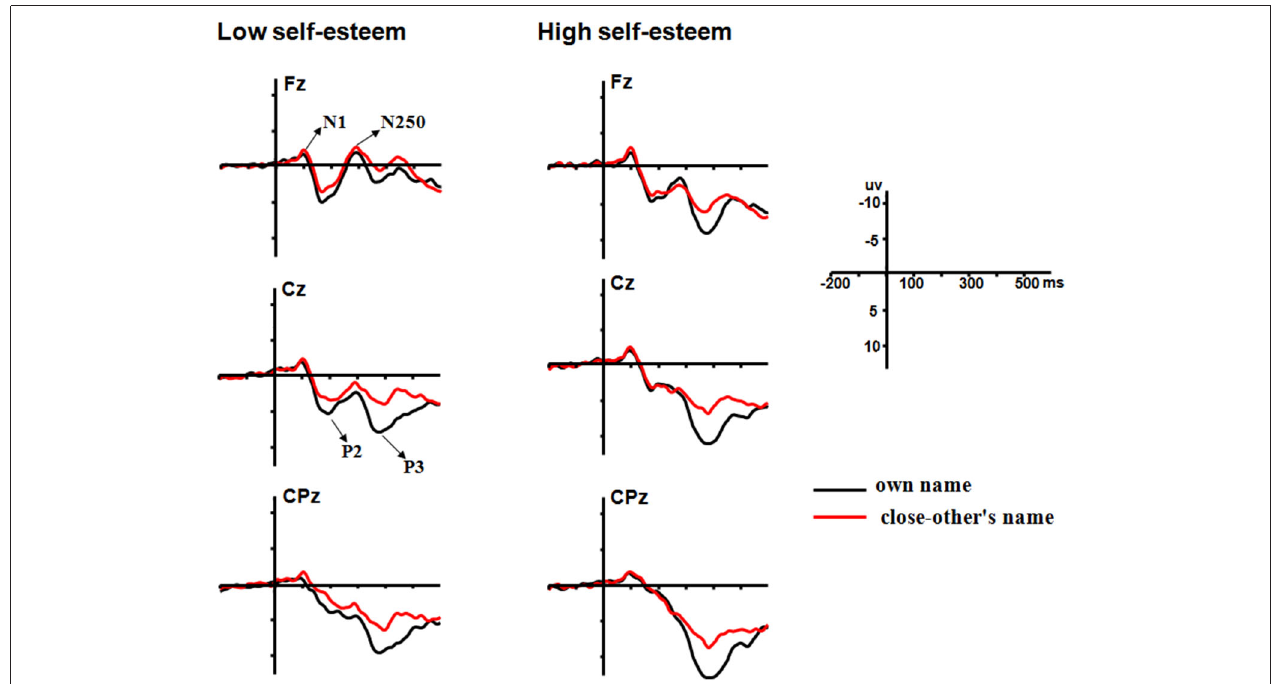
FIGURE 1 | Averaged ERPs at Fz, Cz and CPz to one’s own (black lines) and friend’s (red lines) names for participants with low self-esteem (left panels) and high self-esteem (right panels).